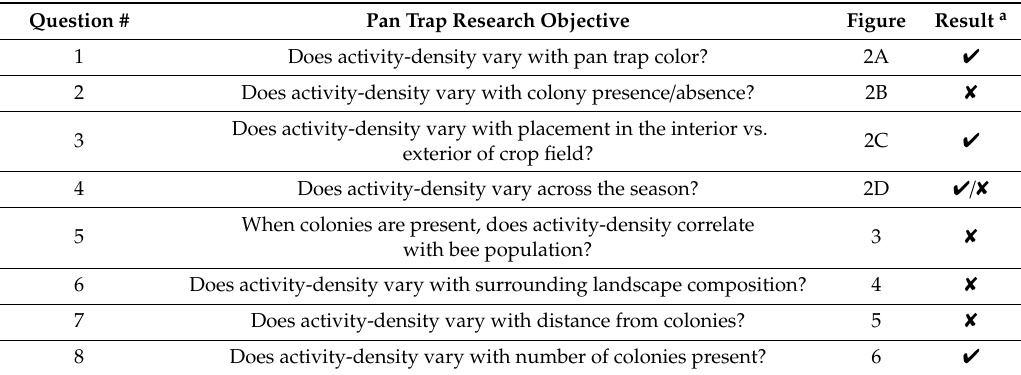
Table 1. Hypotheses related to the usefulness of pan traps as a method to estimate activity-density of honey bees in soybean fields.